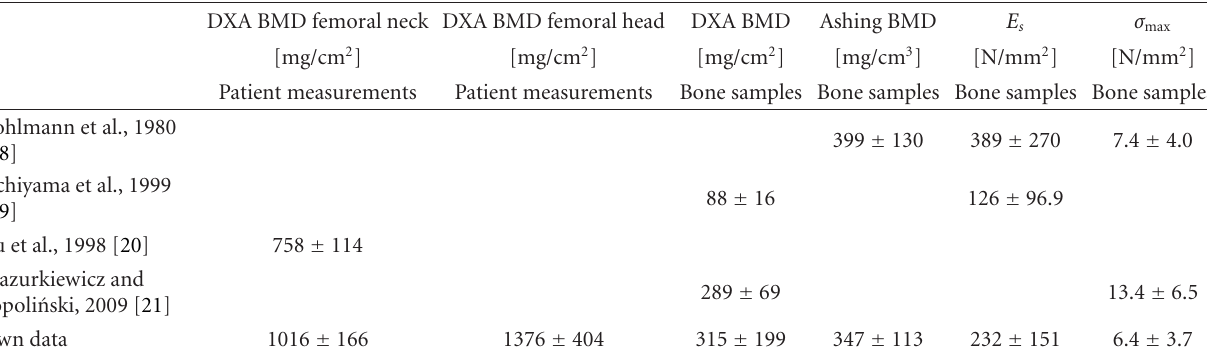
Table 4: Results of BMD testing and mechanical properties of bone samples from the literature compared to own test data.